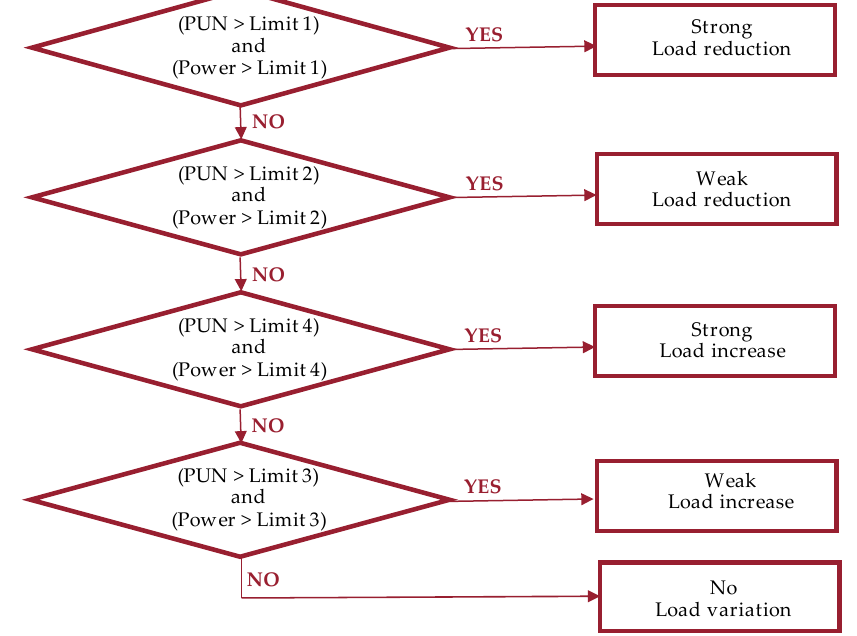
Figure 2. Flow chart related to the consumptions’ optimization process (PUN: National Unique Price).